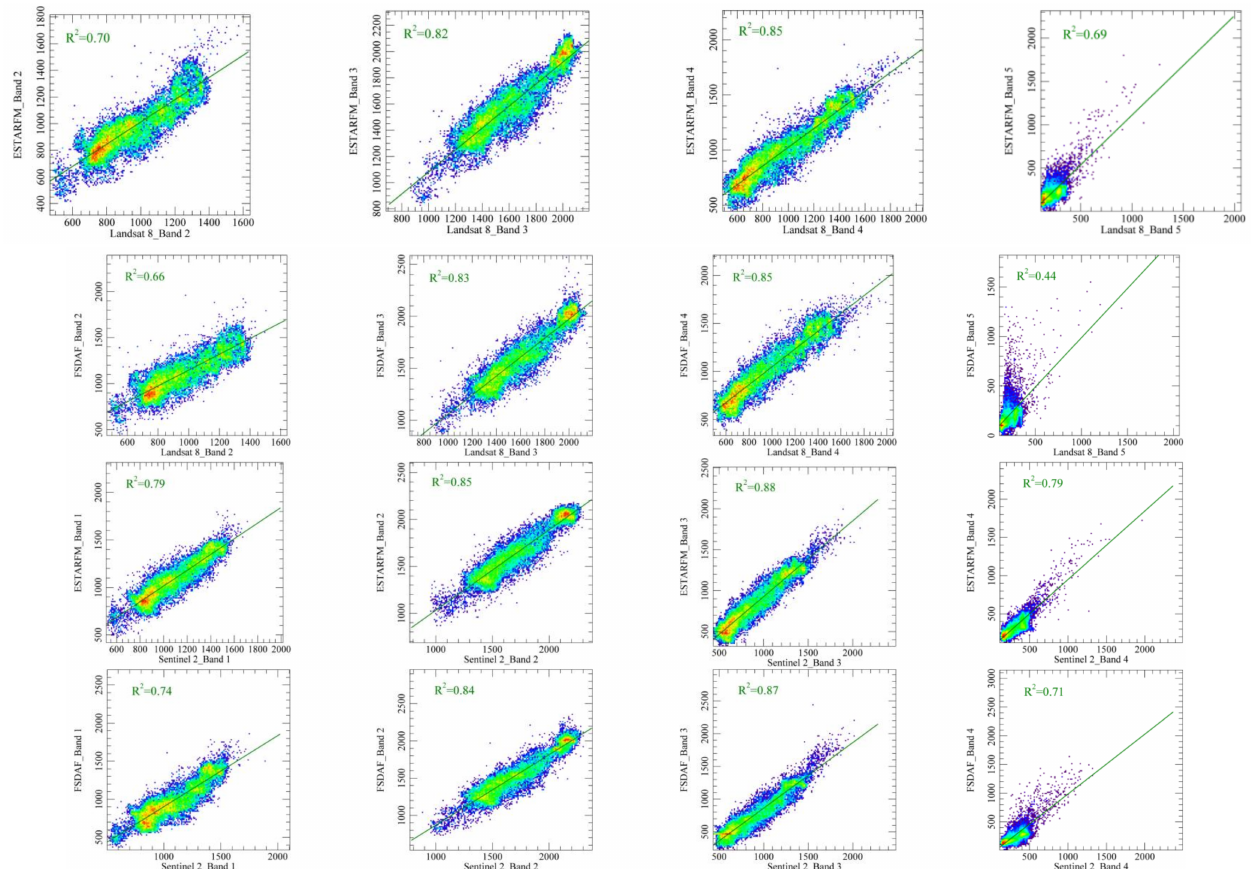
Figure 7. Scatter plots of the correlations (R 2 ) of four spectral